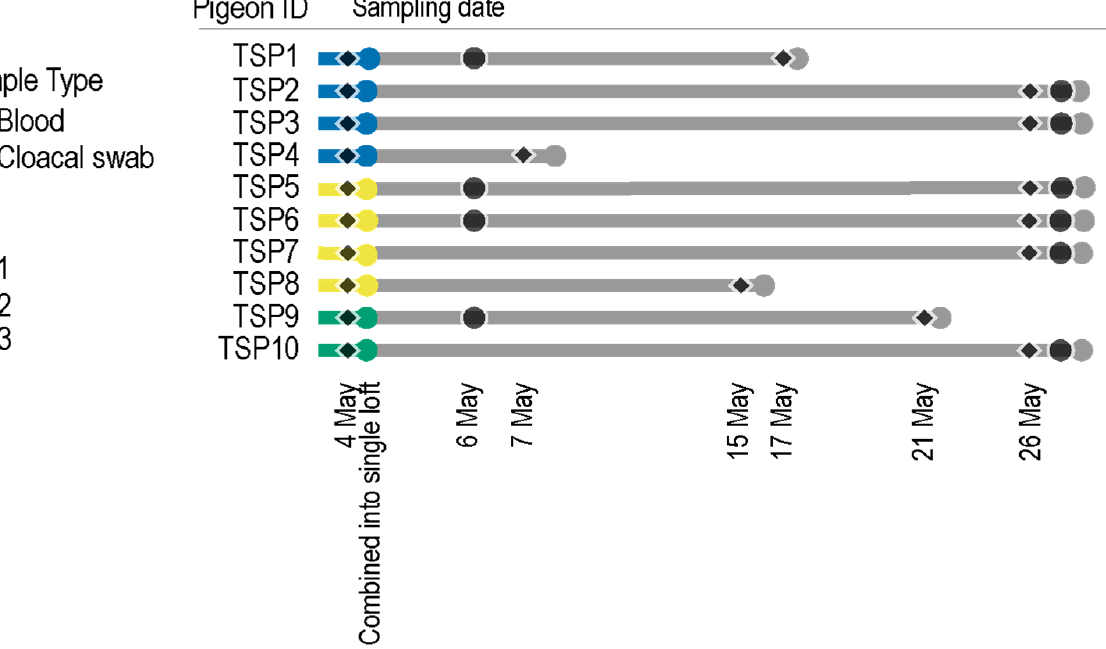
Figure 1. A summary of the timeline of blood and cloacal swab sampling of the pigeons (TSP1-10) for the study.